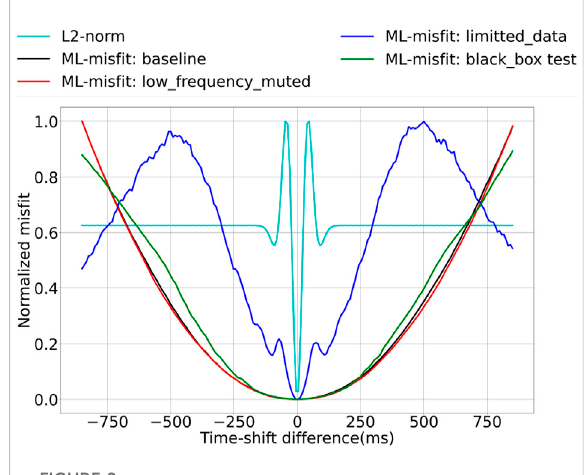
FIGURE 9 Mis fi t curves for the L2 norm and the ML-mis fi t trained with different setups. The main frequency is 10